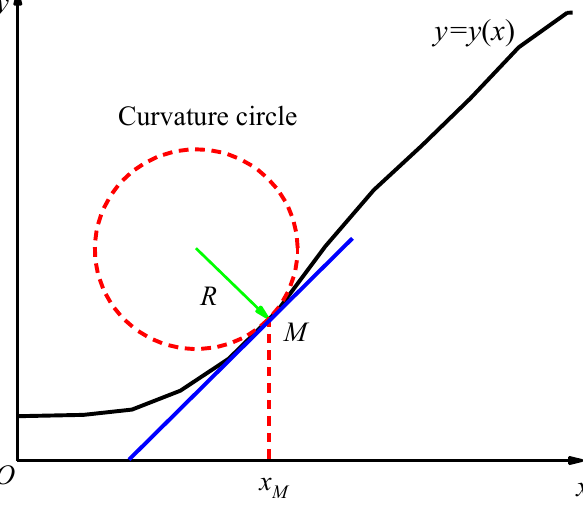
Figure 7. Profiles of L1 with different sampling intervals.